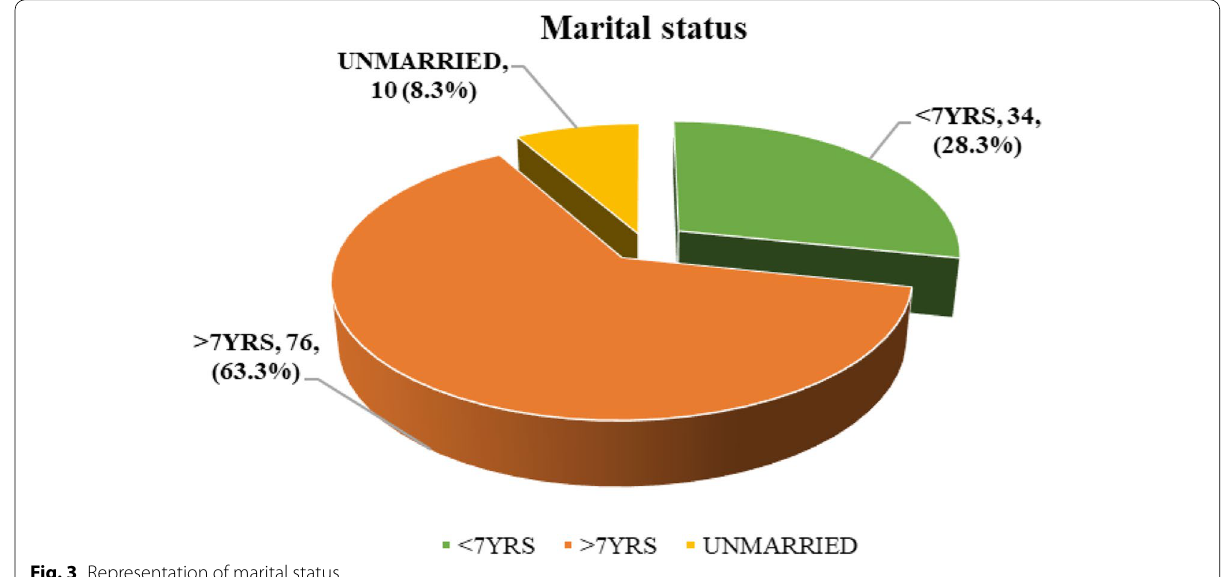
Fig. 3 Representation of marital status